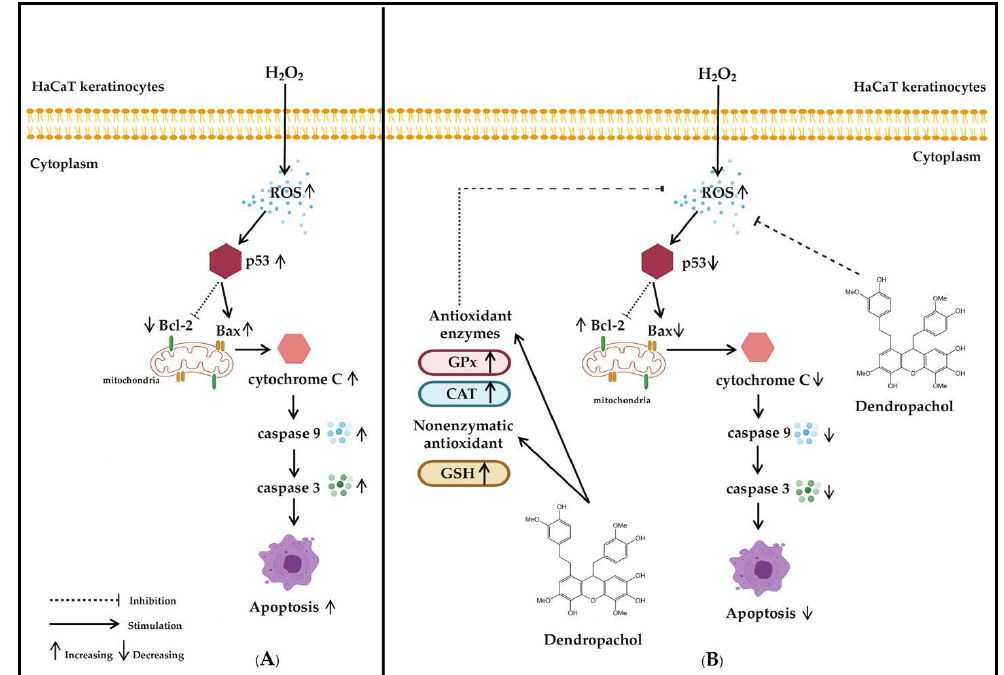
Figure 6. ( A ) Intrinsic pathway of oxidative stress in HaCaT keratinocytes was induced with H 2 O 2 . Enhancement of H 2 O 2 stimulated ROS production led to the protein’s expression of the p53, Bax, cytochrome C, caspase-9 and caspase-3 due to inhibition anti-apoptotic of Bcl-2. ( B ) The molecular mechanism of compound 1 inhibited H 2 O 2 -induced oxidative stress and increased antioxidant enzymes (GPx, and CAT) and level of non-enzymatic antioxidants activities (GPx) in HaCaT keratinocytes. The intracellular ROS production was decreased from compound 1 , GPx, CAT, and GSH. These lead to the decrease of p53, Bax, cytochrome C, caspase-9 and caspase-3 levels and the increase of the anti-apoptotic of Bcl-2 protein.